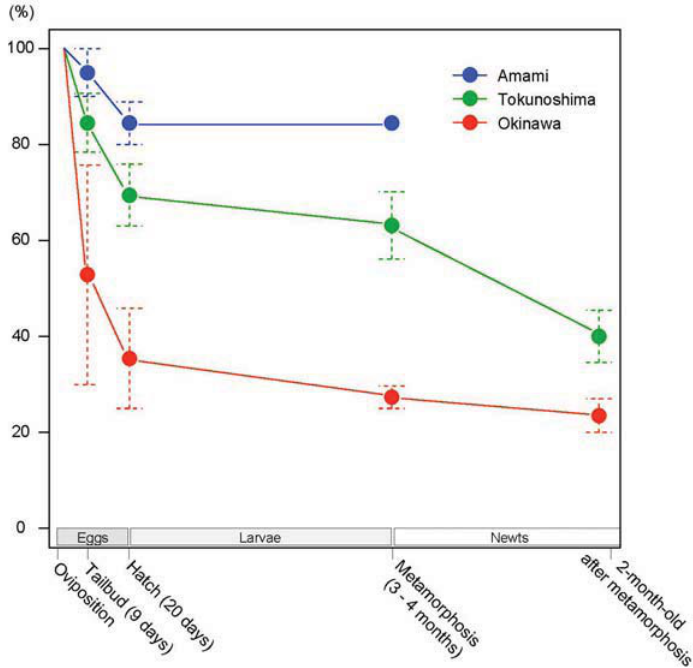
Figure 7. Survival curves showing developmental capacity of the offspring of the Okinawa, Amami, and Tokunoshima Island populations produced through captive breeding in cages in the laboratory setting. Beginning with the deposited eggs, viability at four developmental stages was monitored to evaluate developmental capacity. The vertical bars show the standard error at each